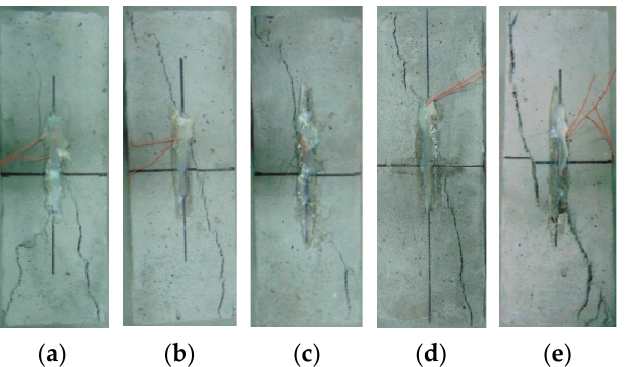
Figure 9. Compressive failure mode of HDC exposed to different temperature treatments. ( a ) − 30 °C. ( b ) 0 °C. ( c ) 20 °C. ( d ) 40 °C. ( e ) 60 °C.